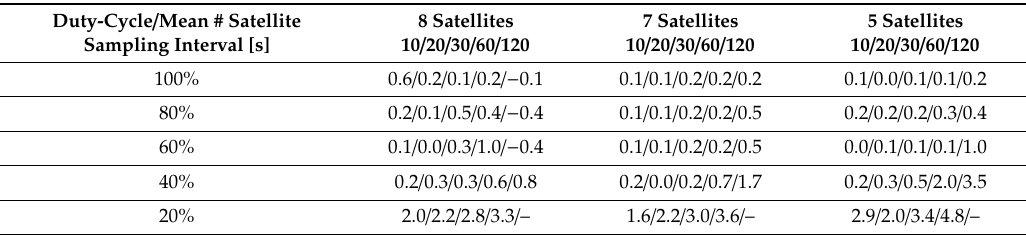
Table 6. Increase in the 3D RMSE (in cm) of phase-based reduced-dynamic orbits when shortening the arc length from 24 h to 12 h. The IGS final products were used.